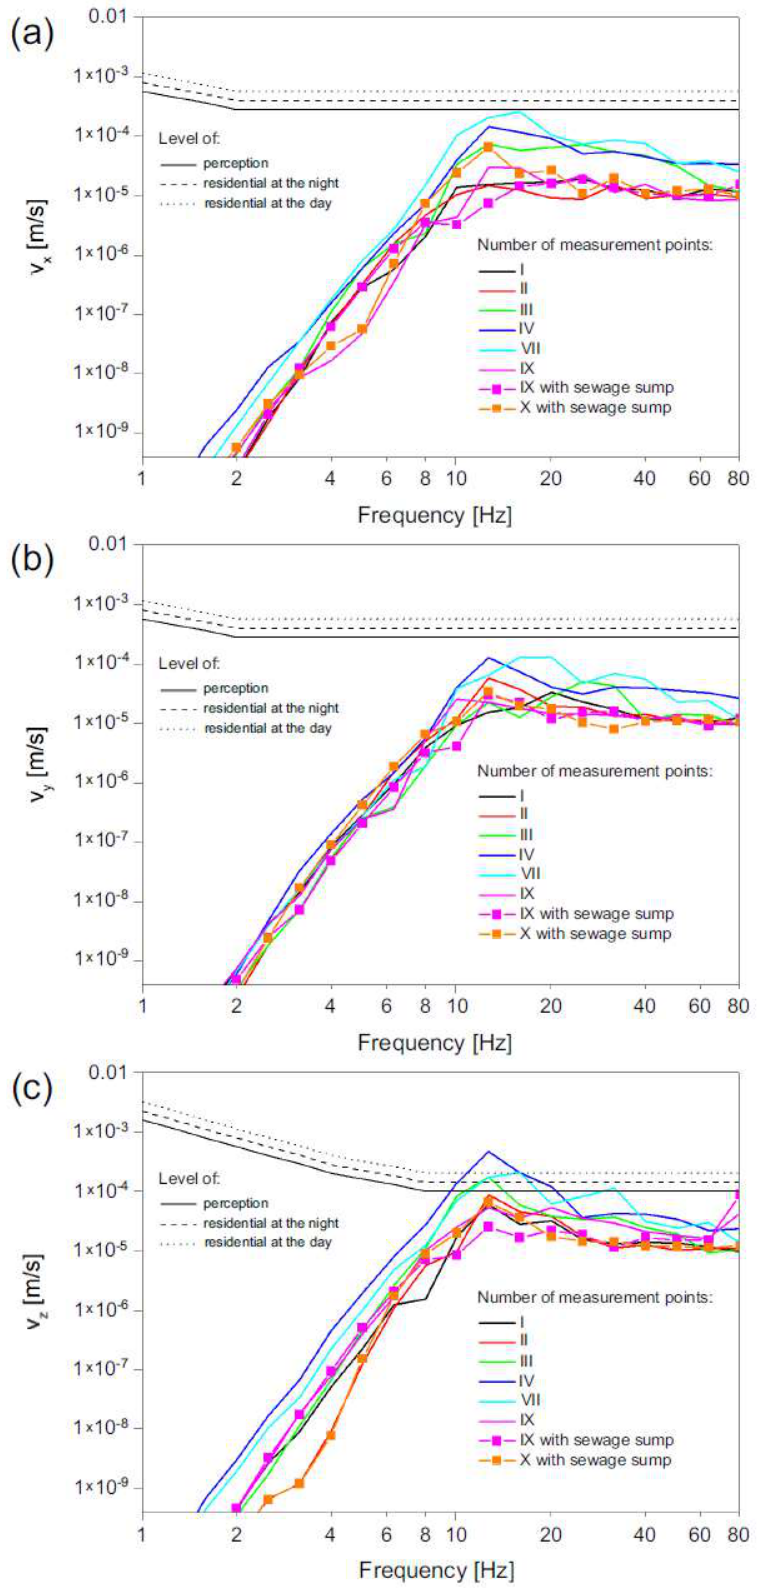
Figure 10. RMS velocity level (speed of 40 km/h) at selected points in: ( a ) x direction (transverse to the road axis), ( b ) y direction (lateral to the road axis), ( c ) z direction (vertical velocity).